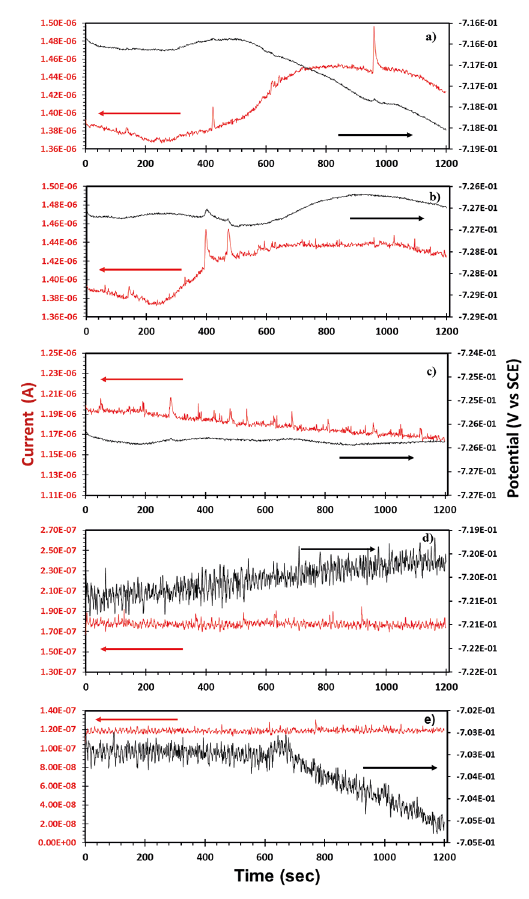
Figure 8. Currents and potential transients of EN for X52 pipeline steel in NS4 solution with pH 8 obtained during SSRT at: a) beginning of the tests, b) elastic zone, c) yield strength, d) UTS and e) before